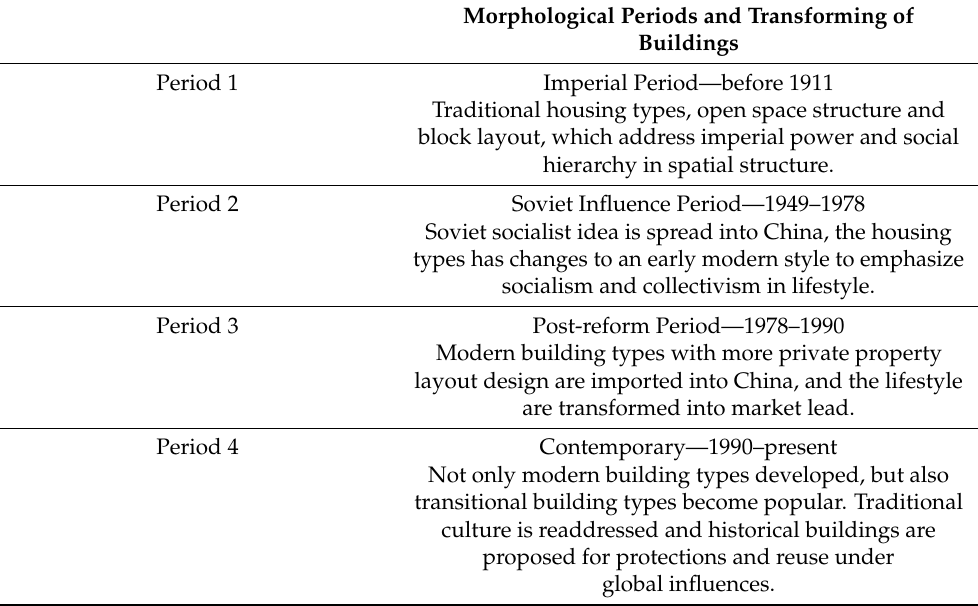
Table 1. Changing of building types over